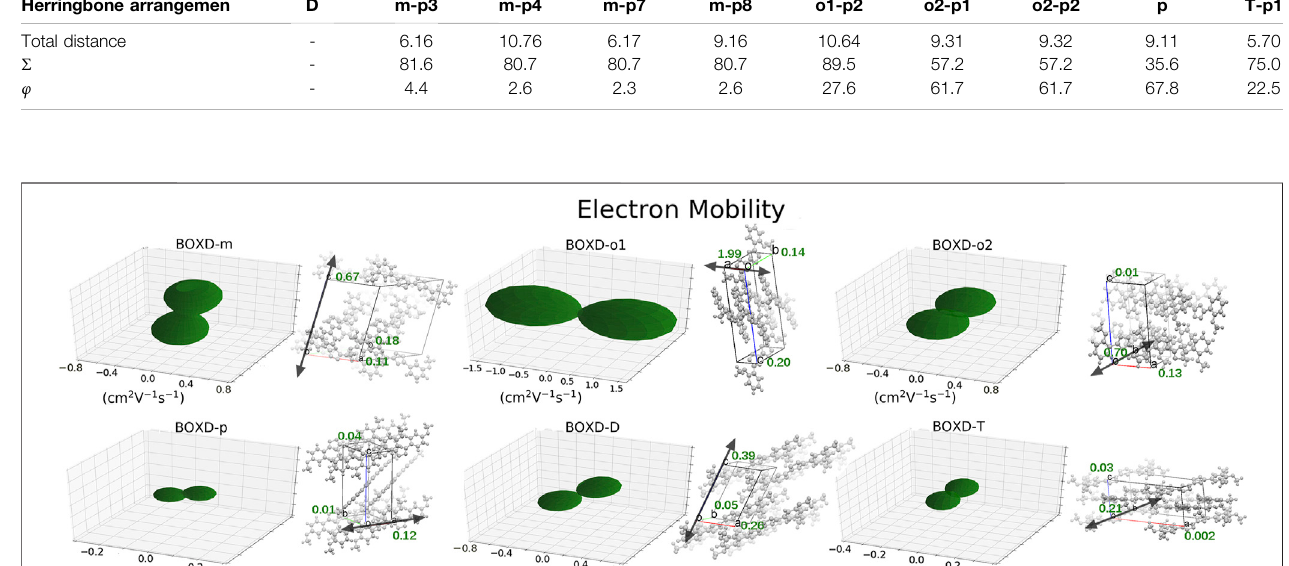
FIGURE 3 | Three-dimensional images of electron mobility in six crystal structures. The mobilities of each direction are next to the crystal cell directions.